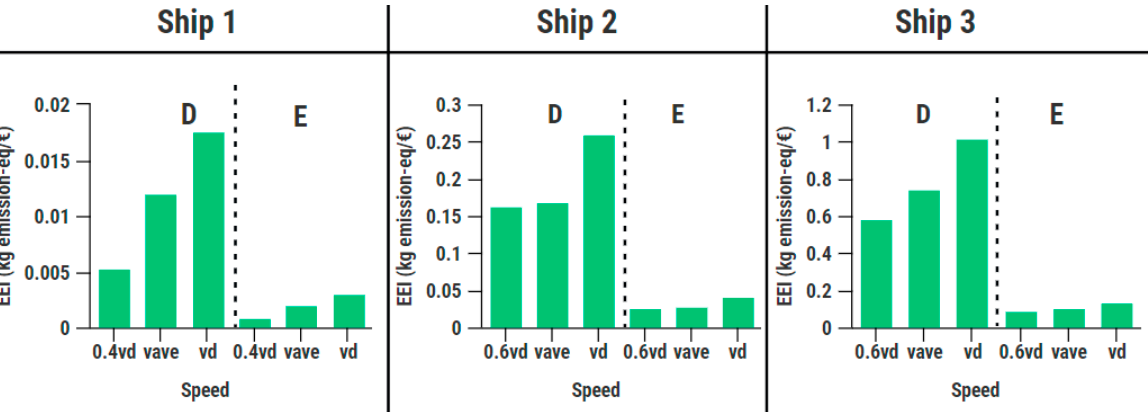
Figure 8. EEI s comparison of diesel-powered ships and electricity-powered ships operating at different speeds.